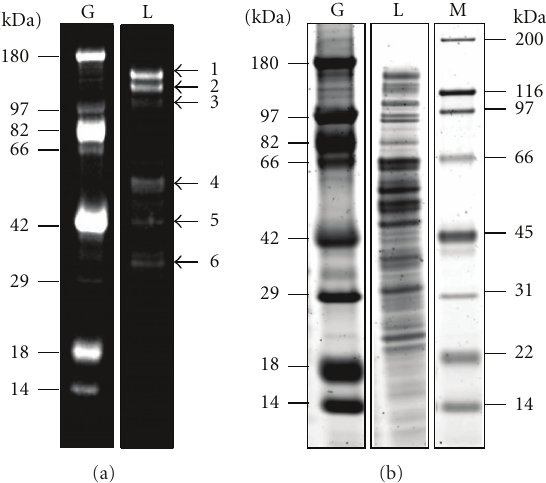
Figure 1: Fractionation of M. barkeri cell proteins by SDS-PAGE. (a) Pro-Q Emerald glycoprotein-stained gel. Lanes: G: glycoprotein stan- dards; L: whole-cell lysate. Gel bands analyzed by LC-MS/MS are numbered. (b) SYPRO-Ruby-stained gel. Lanes: G: glycoprotein standards; L: whole-cell lysate; M: protein standard set 2. Protein sizes are indicated in kDa. The indicated bands 1–6 were excised for LC-MS/MS